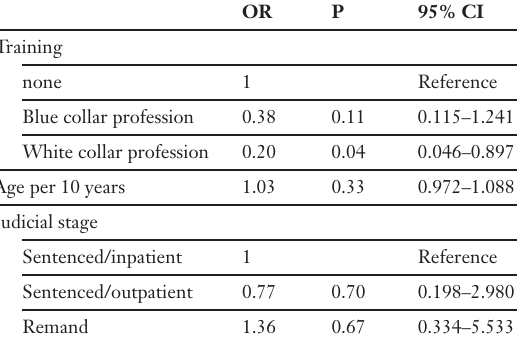
vative estimation) in the three sub-samples were